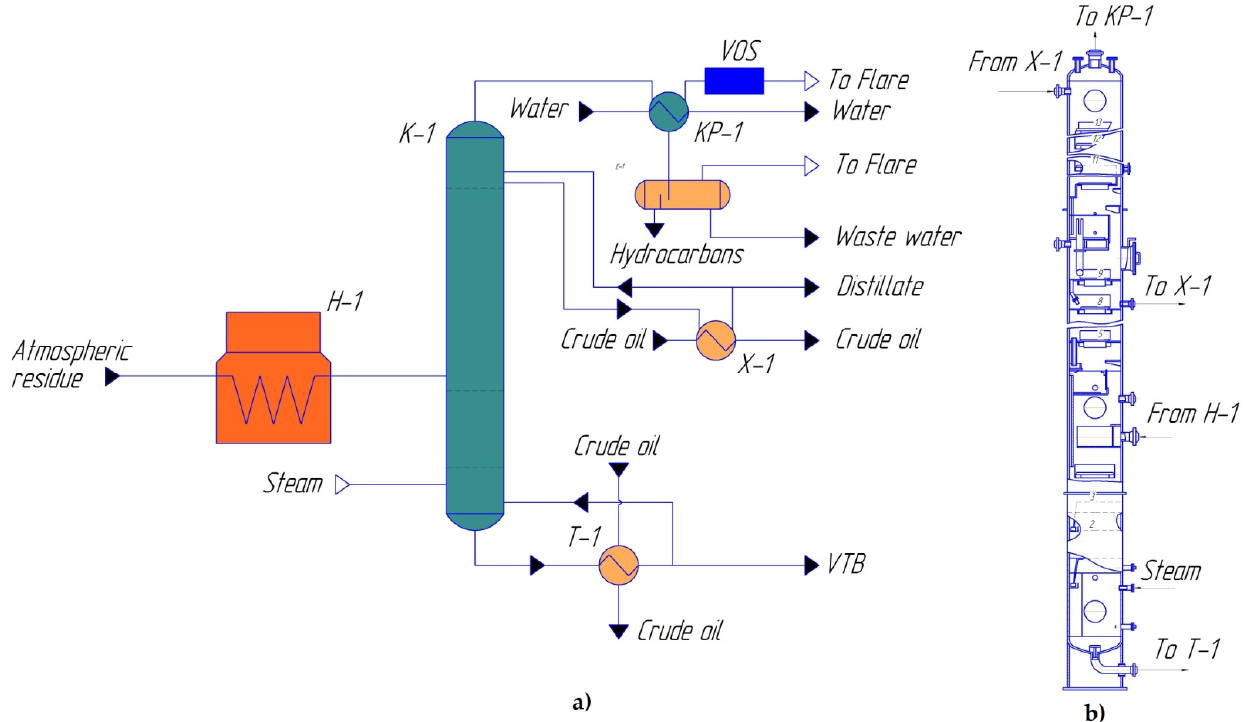
Figure 5. Technological scheme ( a ) and general view of the rectification column ( b ). The main element of the unit is the K-1 vacuum column, which is a vertical cylindrical device of constant diameter with valve plates installed inside. The initial steam–gas mix- ture after heating in the furnace enters the feed stage, where it is divided into streams of